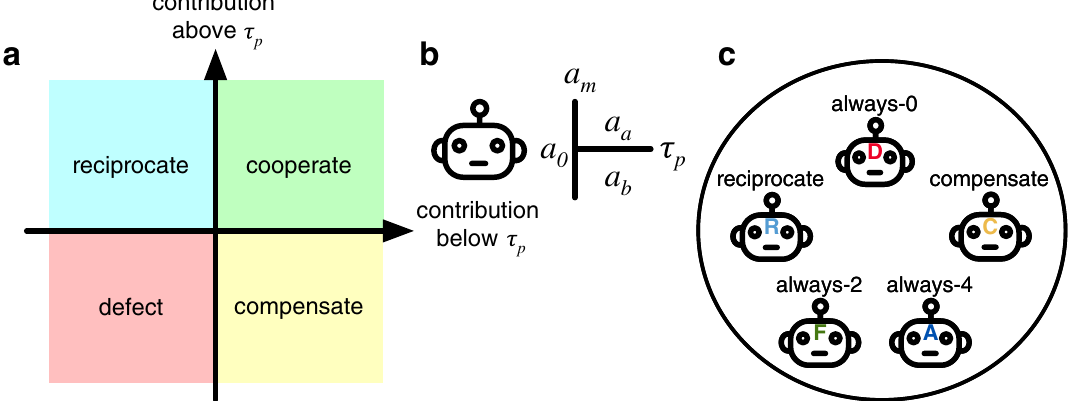
Figure 5. Representation of agent behaviour. Panel ( a ) classifies the behaviour of agents in relation to how much they contribute in response to a stimuli that is above or below a certain personal threshold τ p . When an agent contributes the same positive amount for stimuli below or above the threshold, we say that it cooperates. When it contributes more for values below (above) the threshold, we say that the agent compensates (reciprocates). Finally, when the agent does not contribute, we say that it defects. Panel ( b ) shows a general structure for the description of the agent’s behaviour. An agent has 5 parameters that consist on an initial contribution ( a 0 ), a personal threshold for the external stimuli ( τ p ), and the contributions to be made when the external stimuli is above ( a a ), equal ( a m ), or below ( a b ) τ p . Panel c) represents the pool of agents that can be selected in the delegate treatment. Participants may select between cooperative agents (e.g., always-2, always-4), conditional agents (e.g., reciprocal, compensator) and defecting agents (e.g., always-0), however, these names are not shared with them, and agents are named with letters from the alphabet (e.g., A, B,